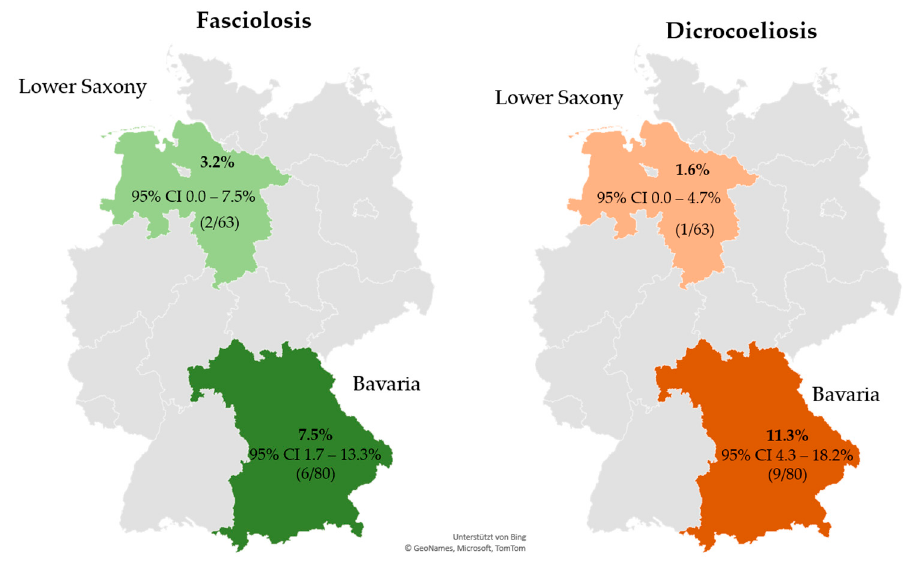
Figure 2. Prevalence of patent fasciolosis and dicrocoeliosis, including 95% CI for goat farms in Bavaria and Lower Saxony. Note that no patent paramphistomidosis was diagnosed in the examined goat herds. Abbreviations: CI, confidence interval.